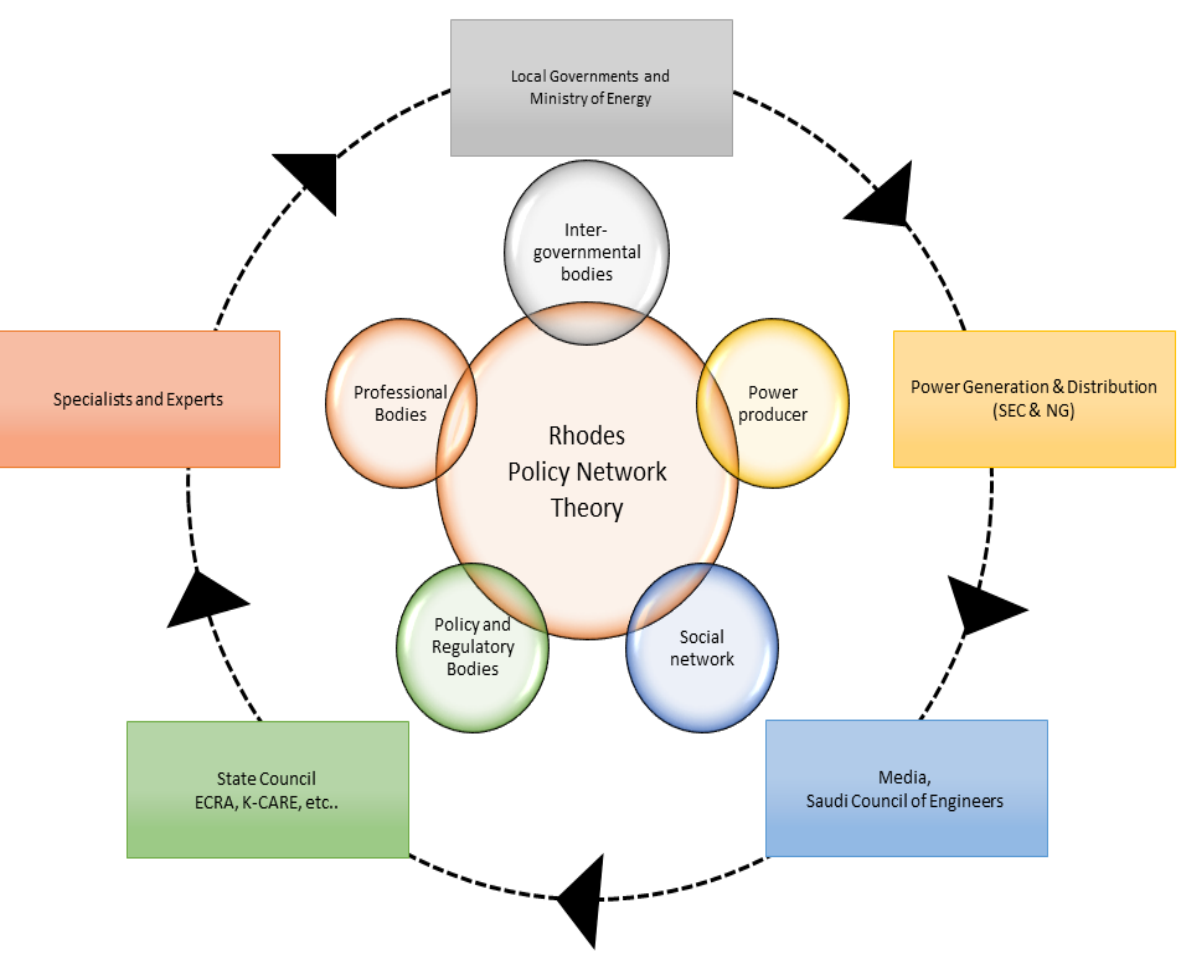
Figure 5. RPS policy network theory model for KSA according to Rhodes’ policy network theory model. RPS policy networks study commences with the classification of different network partakers followed by their position, role and discussions of each. To achieve RPS policy goals, this paper also inspects the particular network’s internal structure, which is an es- sential part of constant and stable communications amongst the different partakers, as well studies the relationship and structure of different networks within the RPS policy networks framework. Partakers’ official structures and affiliations can be re-adjusted with the governmental infrastructural changes to accumulate relevant knowledge. To achieve the stipulated policy aims, RPS policy networks require continuous modifications. Such modifications can affect the strategies and action plans of partakers in the networks and, as result, influence the RPS policy outcomes. The outline of communications amongst dif- ferent networks can change from a decentralized system to a single or multi-center as well as an interdependent and long-term pattern. Different partakers in the networks cooper- ate and build collaboration with each other for the establishment and implementation of RPS. 3. Findings and Discussion The renewable portfolio standard includes interacting and exchanging resources be- tween multiple partakers and the demands of other partakers. The analysis of the interac- tions, structure and type of partakers is usually carried by the application and scope of